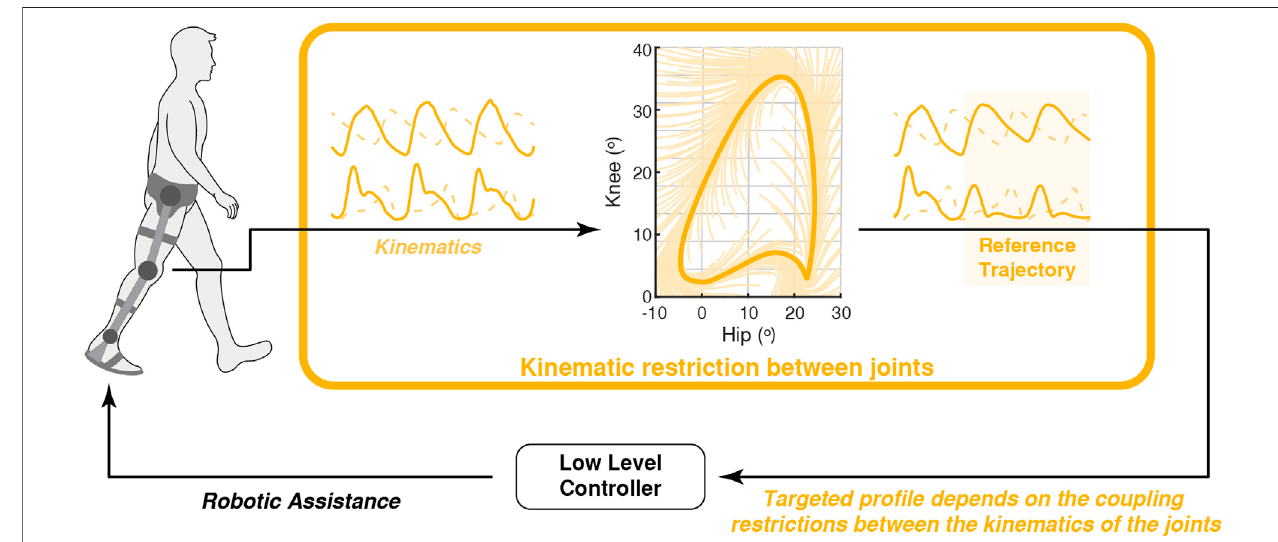
FIGURE 5 | Conceptual representation of the robot-gait coordination based on the kinematics of the gait: a fl ow control imposed restrictions between the movement of hip and knee to generate the assistive pro fi le that is applied by the robot.